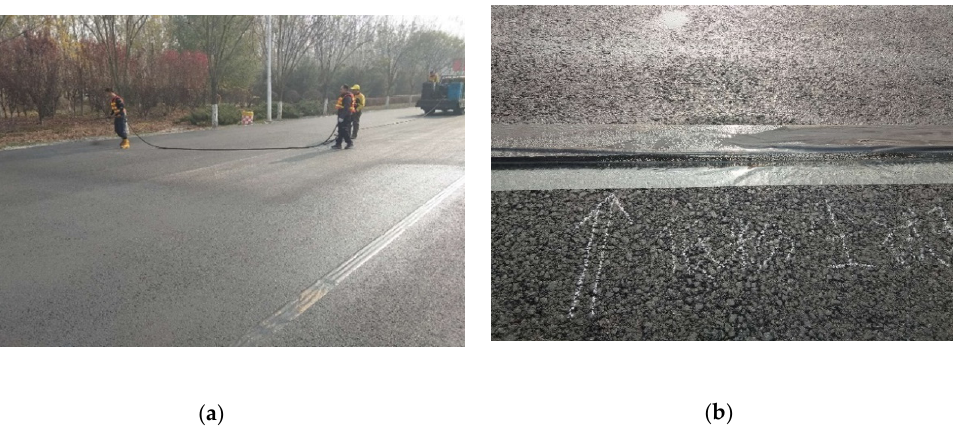
Figure 9. Spreading of functional Sand-fog seal: ( a ) Spraying; ( b ) Spray complete.